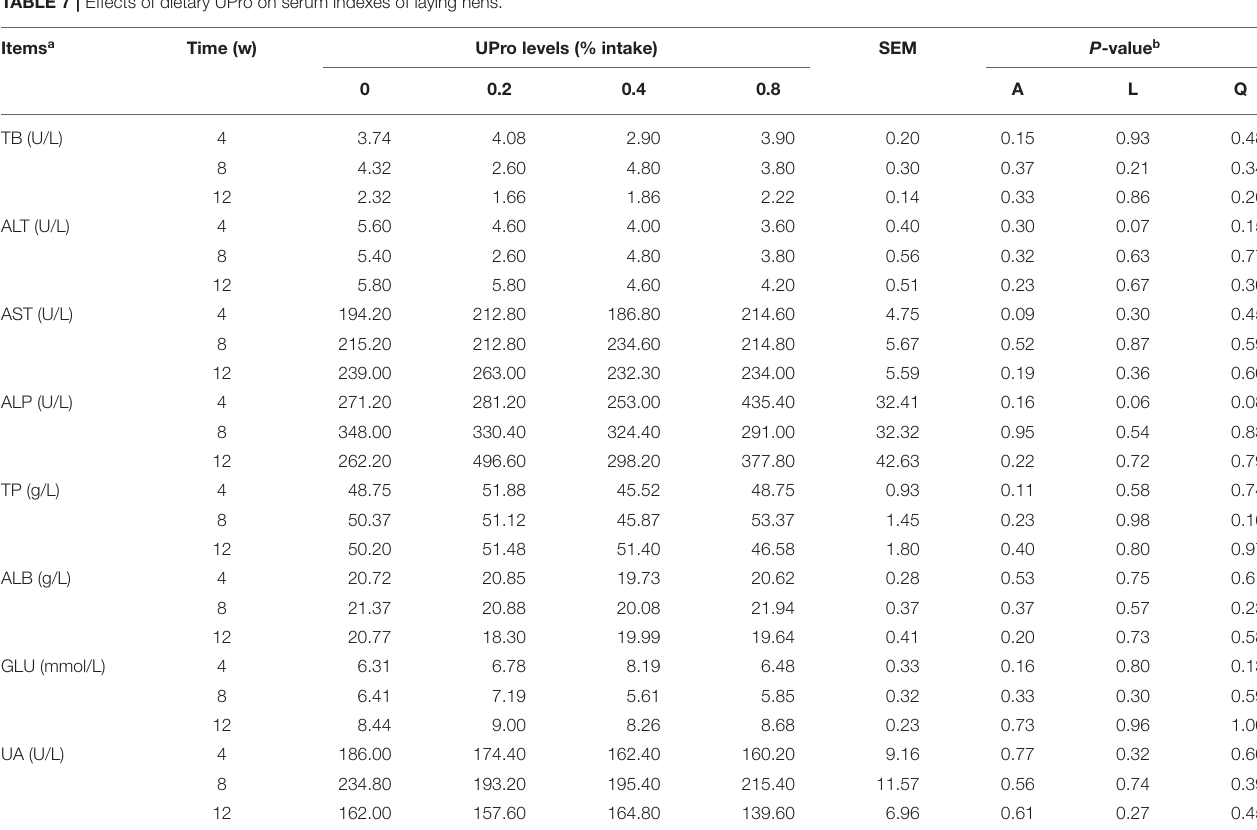
TABLE 7 | Effects of dietary UPro on serum indexes of laying